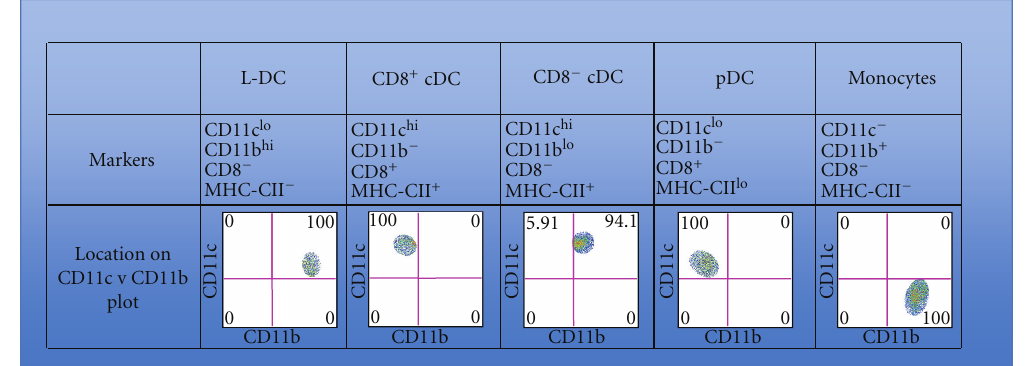
Figure 2: Classification of DC and myeloid subsets in spleen. Subsets in spleen can be identified flow cytometrically in terms of their phenotype following staining with specific antibody to cell surface markers. The di ff erent subsets can be identified based on variant expression of CD11c, CD11b, CD8 α and MHC-II. The phenotype of L-DC is shown by comparison with pDC, cDC and a broad monocyte population. The di ff erent subsets can also be located in distinct positions on a bivariate CD11c versus CD11b scatter